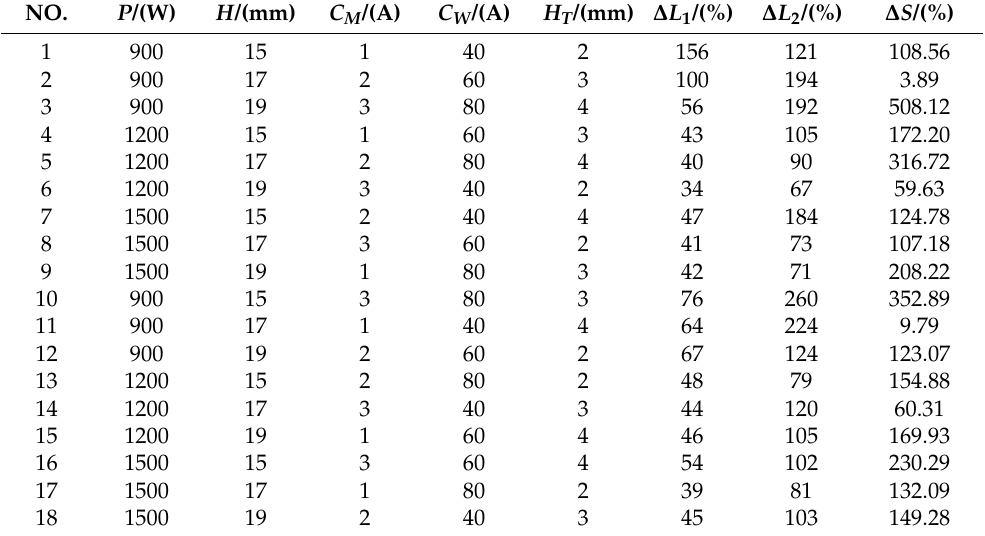
Table 1. The orthogonal experimental table and